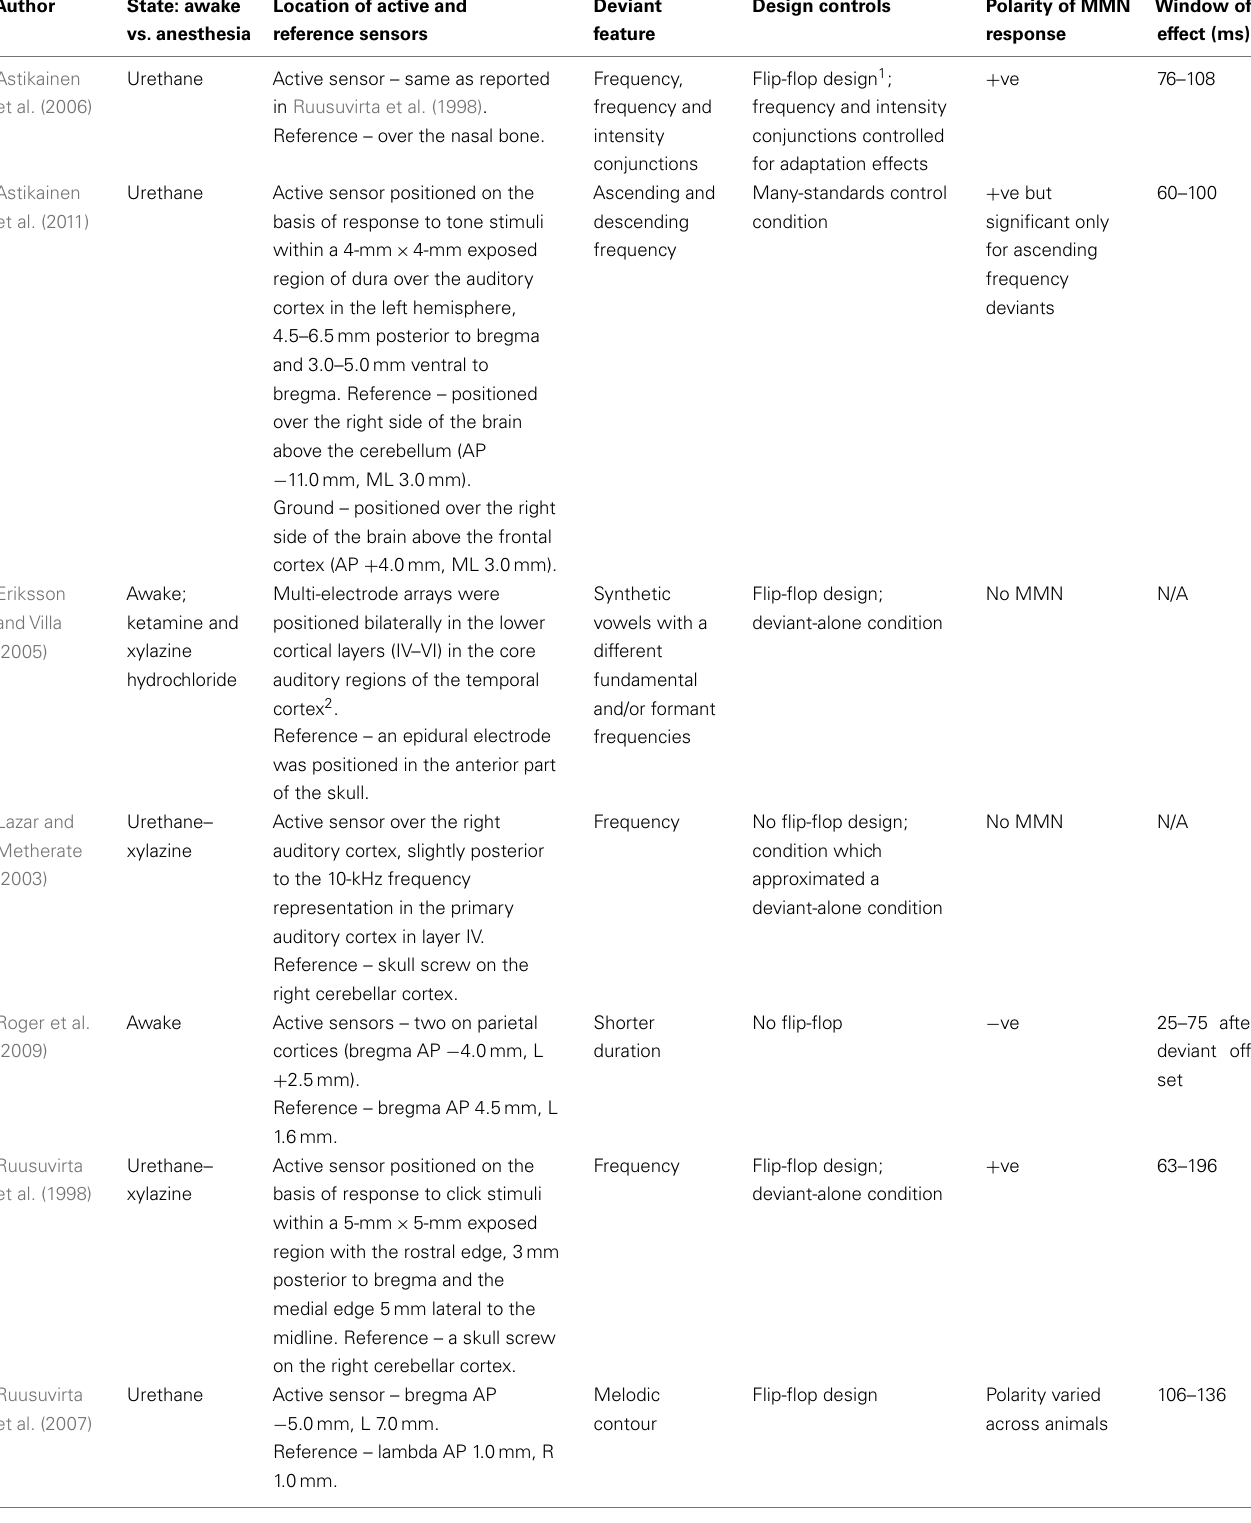
Table 1 | Summary of previously published papers on epidural mismatch negativity (MMN) potentials in rats showing details of animal